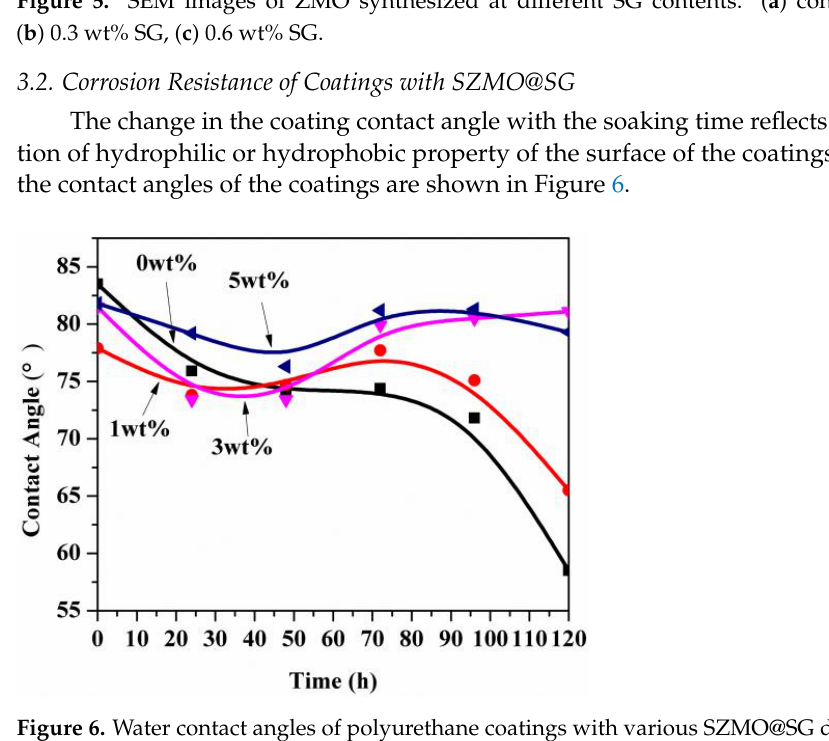
Figure 5. SEM images of ZMO synthesized at different SG contents. ( a ) control without SG; ( b ) 0.3 wt% SG, ( c ) 0.6 wt% SG.